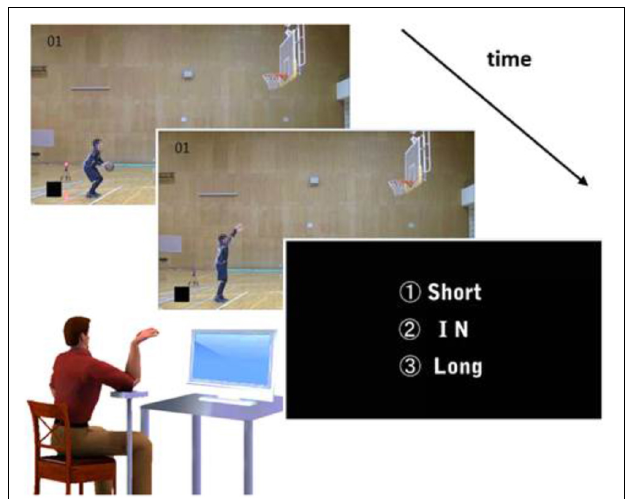
FIGURE 1 | Experimental apparatus and setup. Participants were required to predict shot outcomes using the kinematics of a model’s basketball free throw, as viewed in movies in which the ball trajectory was occluded, in observation, incongruent-action, imitative-motion, and self-motion conditions. At the end of each movie presentation, three instruction frames appeared, which asked the participant to respond verbally as to where the basketball would land (i.e., “short,” “in,” or “long”). In the observation condition, participants predicted shot outcomes based on simple observation of the presented stimuli. In the incongruent-action condition, they executed right-wrist flexion with maximum speed. In the imitative-motion condition, they executed right-wrist flexion as if imitating the model’s action. In the self-motion condition, they executed their right-wrist flexion as if taking the shot themselves. The model player gave us the consent for the publication of this